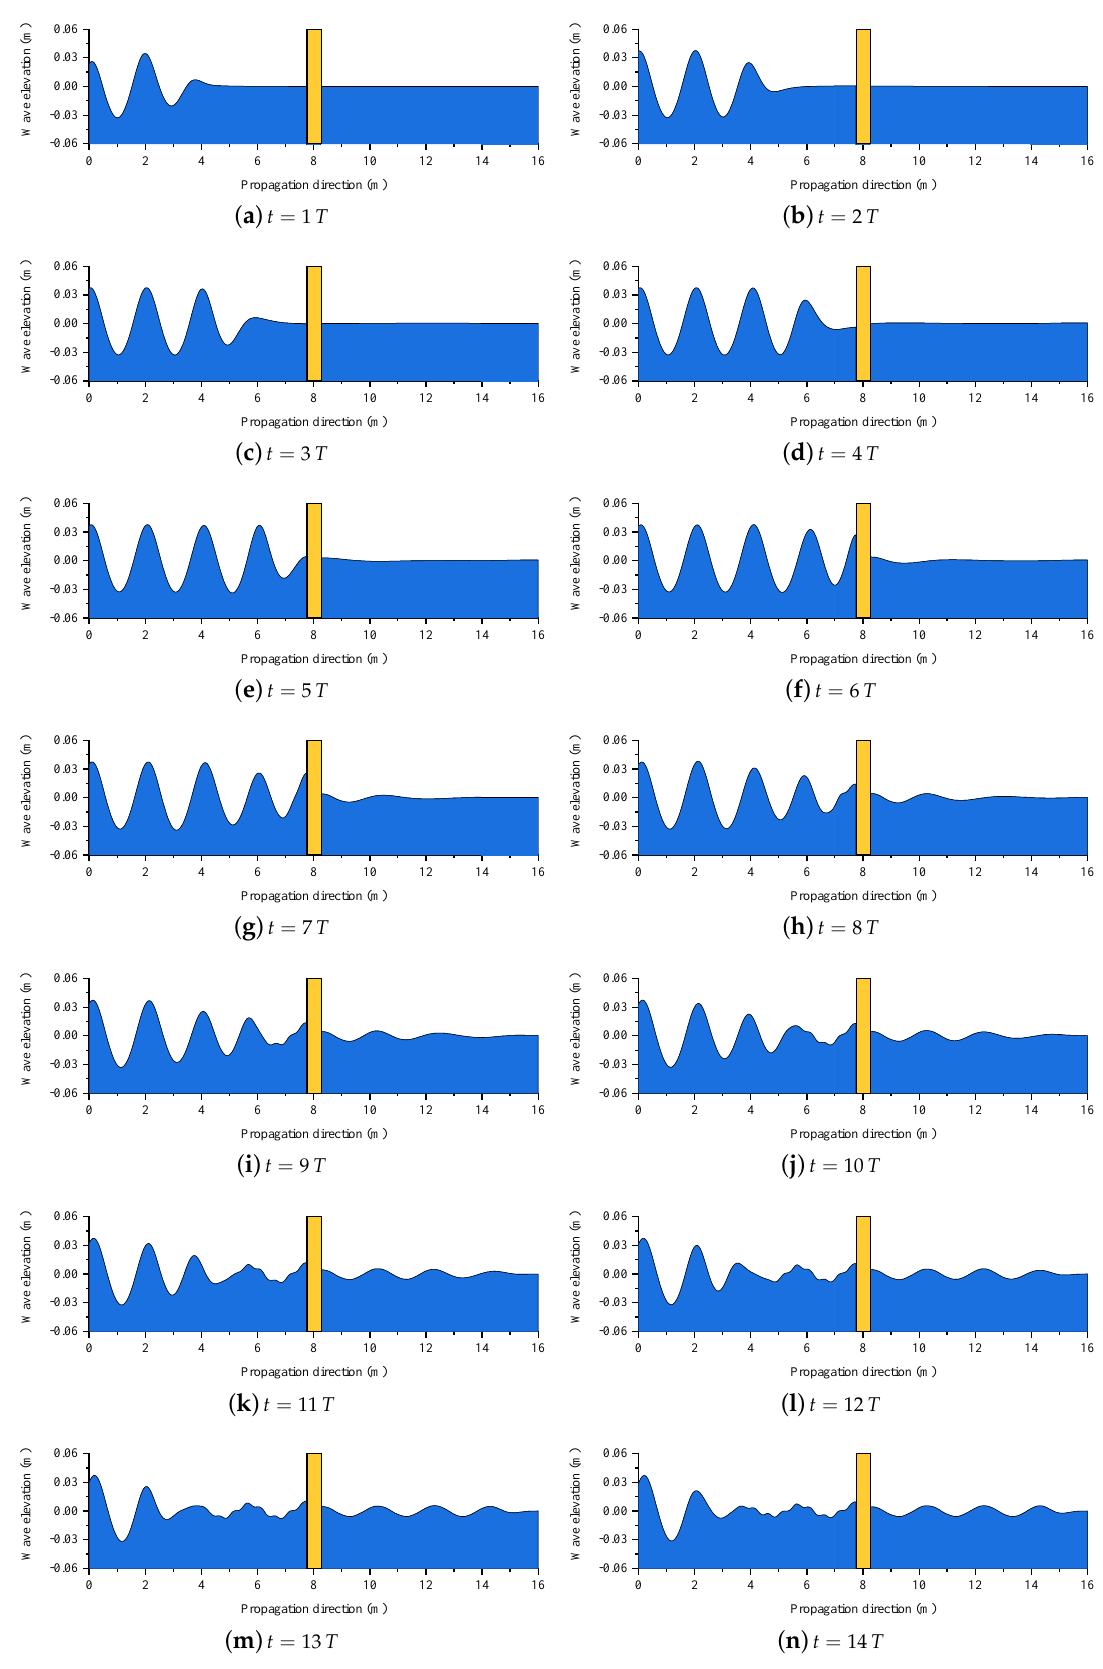
Figure 10. Profiles of free surface along the developed NWF at different time slices. λ = 2.0m and wave height H =